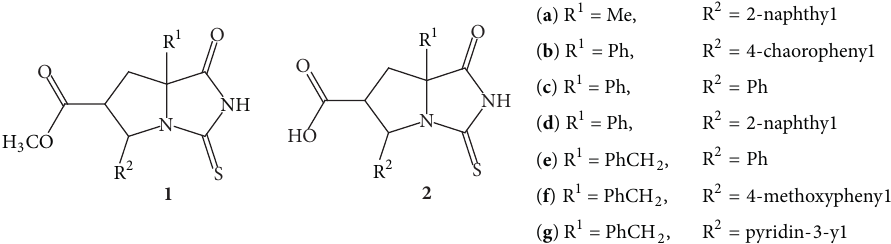
Figure 1: Methyl ester of thiohydantoin-pyrrolidine compounds ( 1a–g ) and their hydrolysis products in acidic media ( 2a–g ).